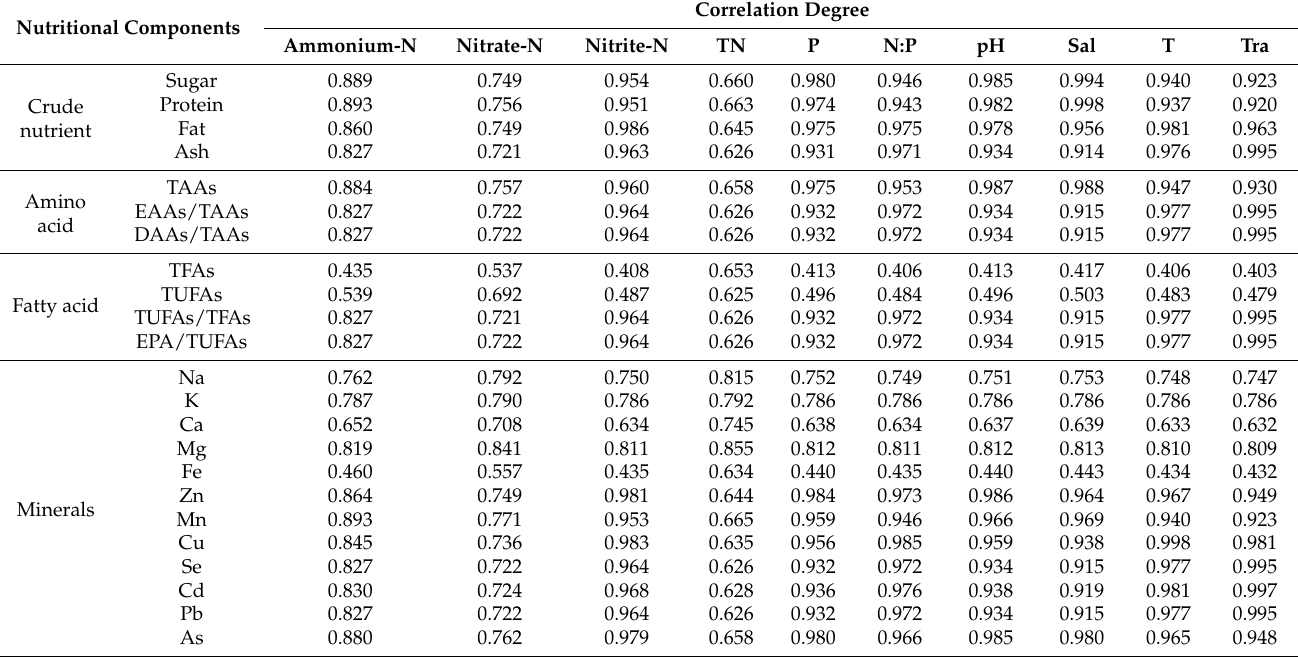
Table 7. Gray correlation coefficients between the contents of crude nutrient, amino acid, fatty acid, and minerals in N. haitanensis and related ecological factors. The abbreviations were the same in Table